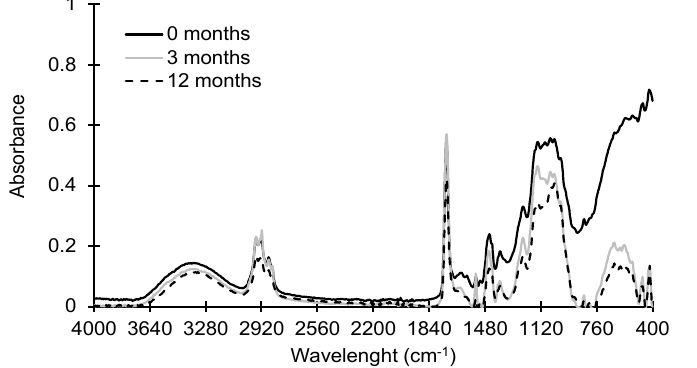
Figure 1. ATR-FTIR spectra of paint dust generated by sanding using P120 sandpaper after 0, 3, and 12 months of environmental weathering.